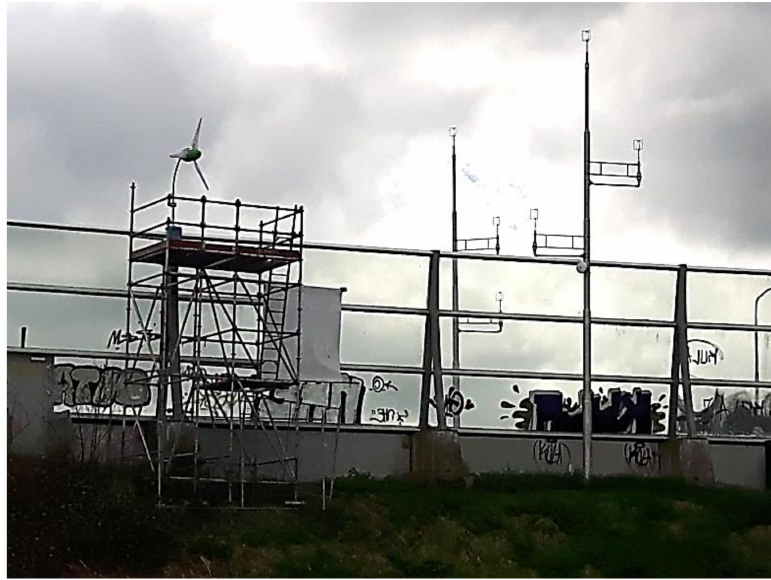
Figure 7. Micro wind turbine integrated on noise barrier field experiment. The 6 sonic anemometers are visible on the right located on two masts on three heights. The scaffolding behind the barrier is for access purposes and does not influence the incoming flow over the